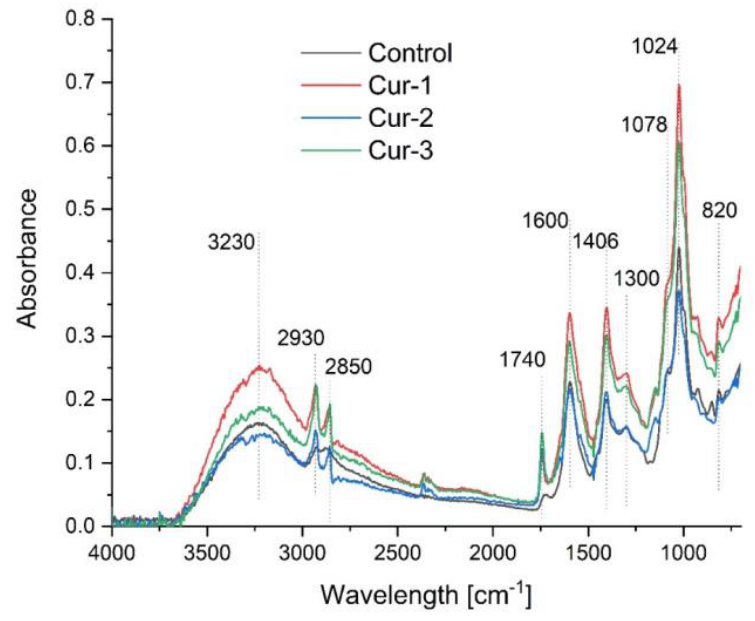
Figure 2. ATR-FTIR spectra of the control film and composites containing nanocapsules.